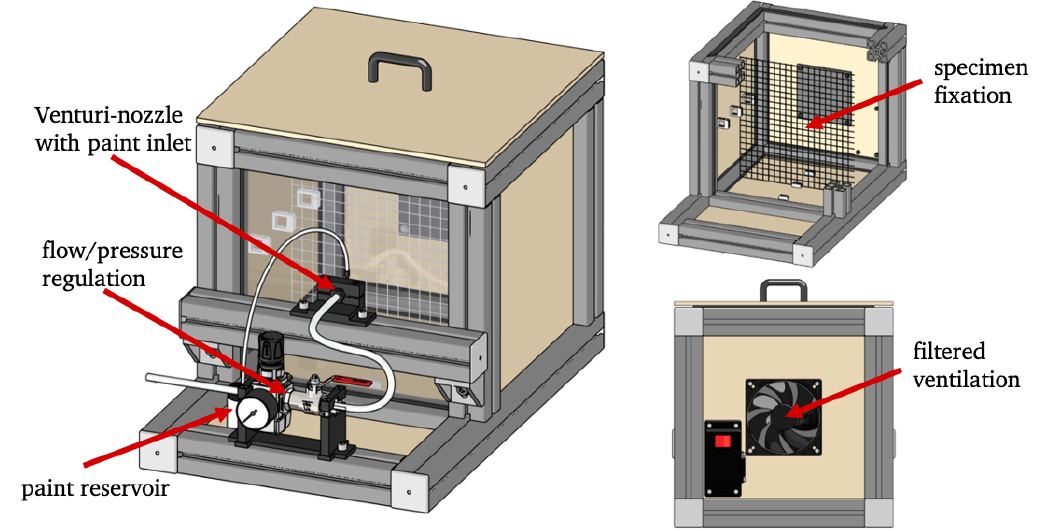
Figure 2. Setup to produce perfect speckle pattern for each individual DIC